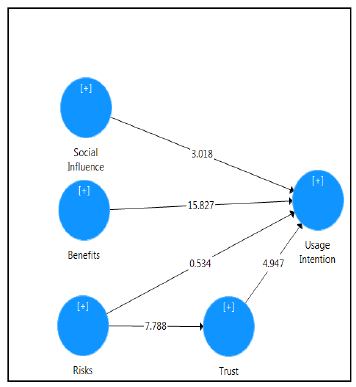
Figure 2. Results of hypotheses tests.